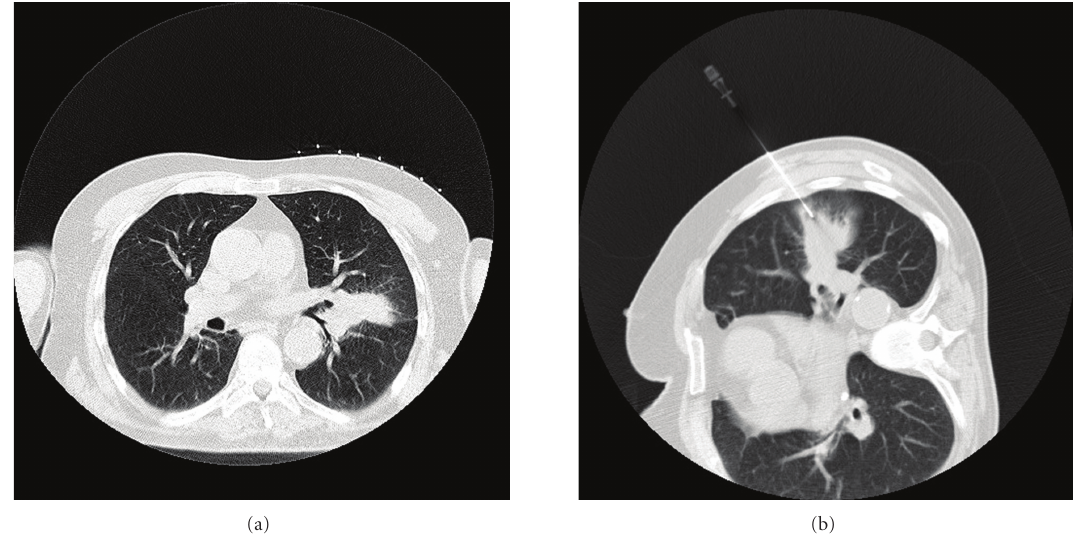
Figure 1: 64-year-old man with lung lesion: (a) CT scan of chest in supine position shows left-sided lung lesion. (b) A 19-gauge needle has been positioned within the lesion under CT guidance and core biopsy is then performed using coaxial